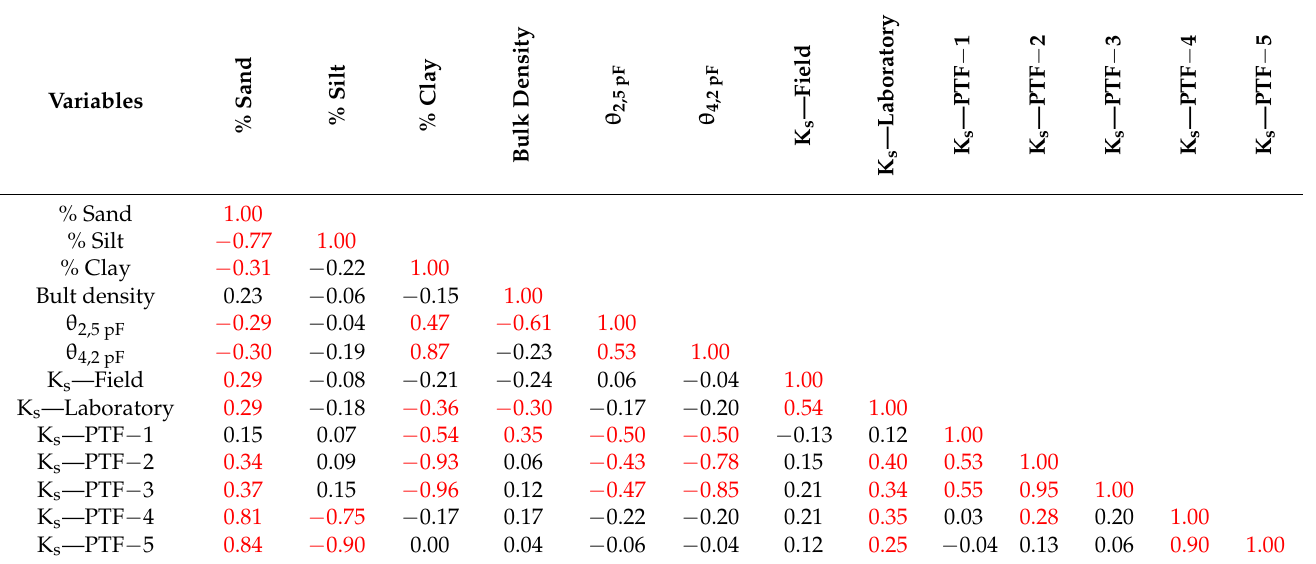
Table 7. Spearman’s rank correlations coefficients ( rho ) between measured and predicted saturated hydraulic conductivity ( K s ) and other selected soil physical properties.